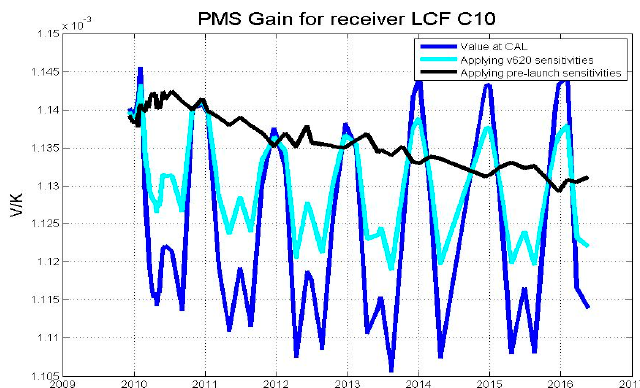
Figure 6. SMOS PMS gain for receiver LCF_C10 over the years. The blue line indicates the value as measured during the calibration event at the physical temperature during the calibration event. The cyan line and black line show the PMS gain transported to 21 degrees Celsius using the second mission reprocessing and pre-launch PMS sensitivities, respectively.